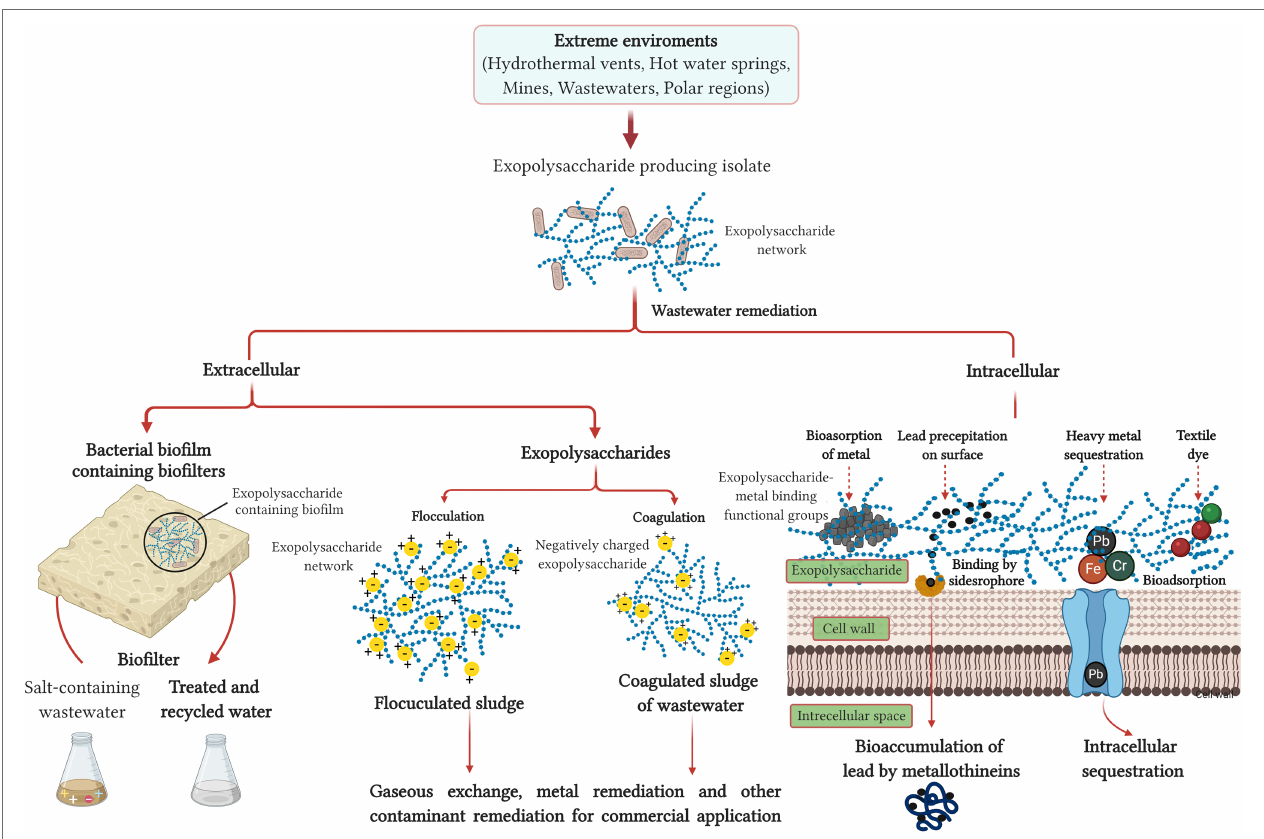
FIGURE 1 | The generalized concept of exopolysaccharide (EPS) produced by extremophilic bacteria and its different wastewater treatment